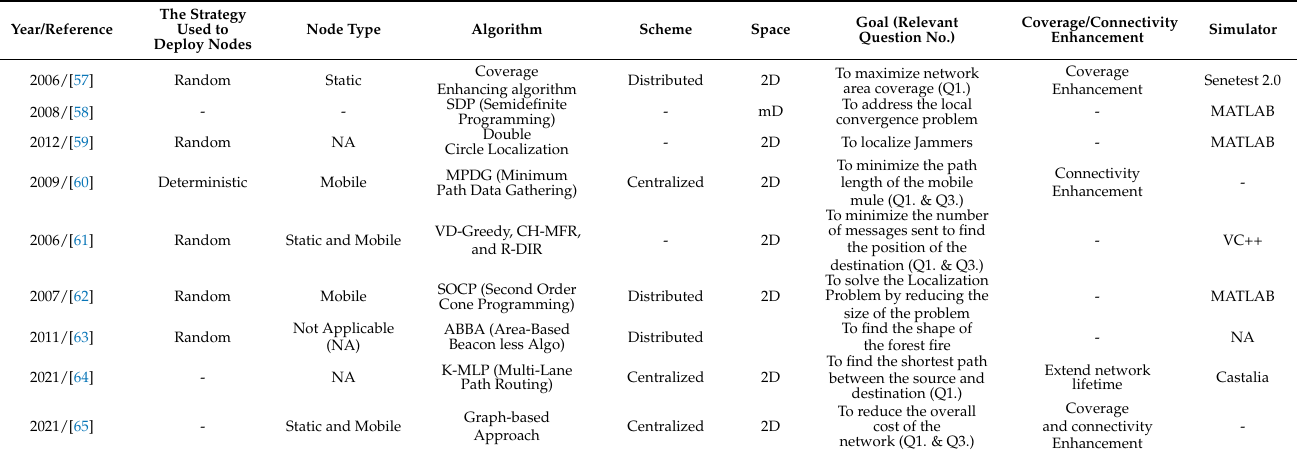
Table 5. An Overview of the Different Convex Hull-Based Techniques to Improve Coverage and Connectivity in